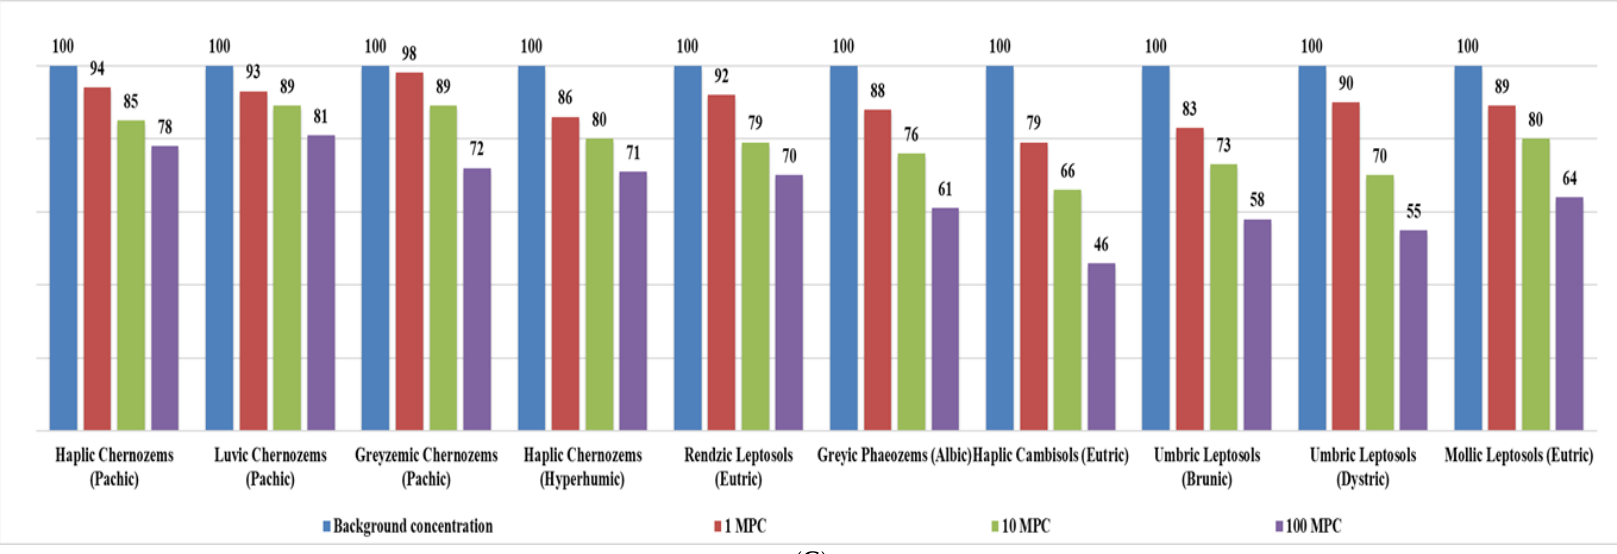
Figure 1. The effect of lead (Pb) contamination on the biological parameters of forest, forest-steppe, steppe, and mountain-meadow soils (% of control): ( A ) — the catalase activity, ( B ) — the activity of dehydrogenases, ( C ) — total number of bacteria, ( D ) — the abundance of bacteria of the genus Azotobacter , ( E ) — the phytotoxic properties (length of radish roots), ( F ) — the cellulolytic activity, ( G ) — the integral indicator of the biological state (IIBS).